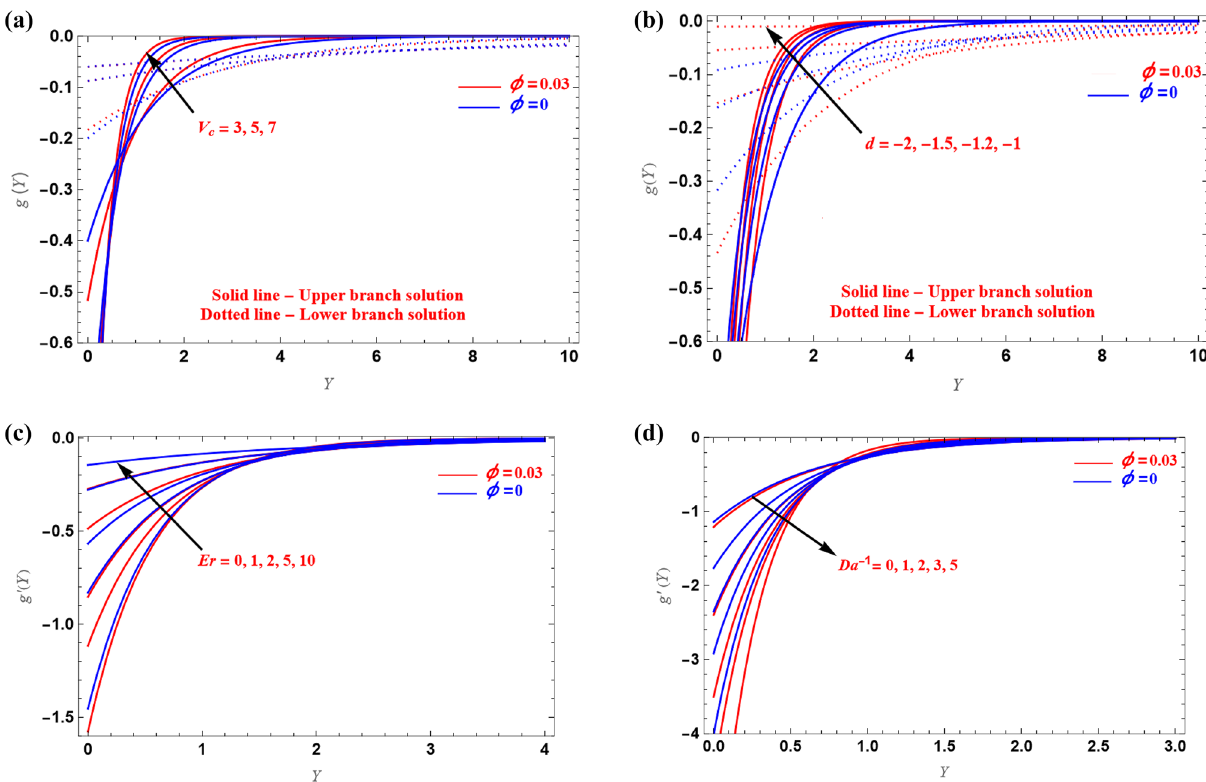
Figure 5. ( a – d ) Illustration of g ( Y ) verses Y and g ′ ( Y ) verses Y